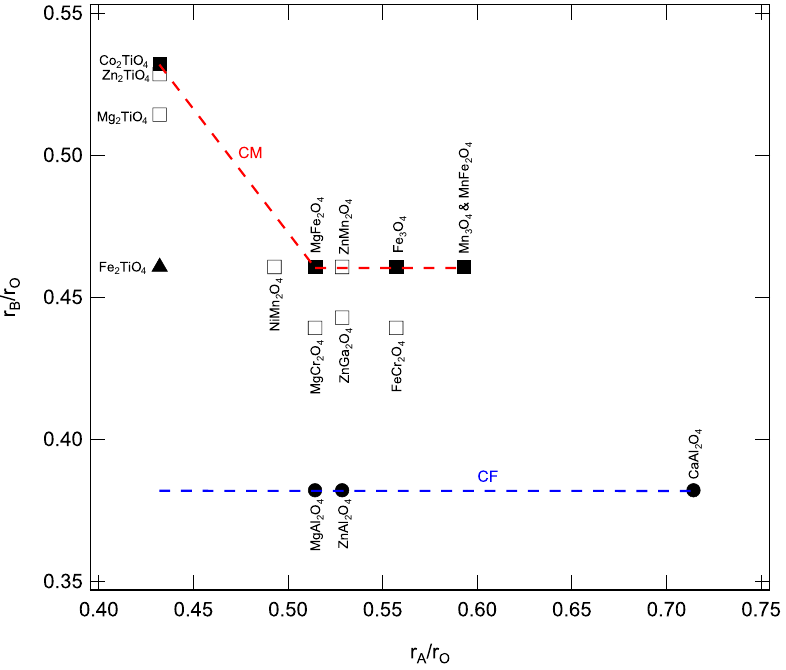
Figure 8. The radius ratio r A /r O versus r B /r O . for different spinels. Four different post-spinel structures, CT (solid triangle), CF (solid circle), tetragonal (open square), and CM (solid square), are shown. There are two curves which show the trends of CM (red) and CF (blue) post-spinel phases, respectively. The trend of CF at lower r A /r O is calculated from 47 . Different post-spinel phases lie in the small region of r A /r O < 0.45 and r B / r O > 0.5. The regions of CM and tetragonal are quite close, but the trends between CM and CF are